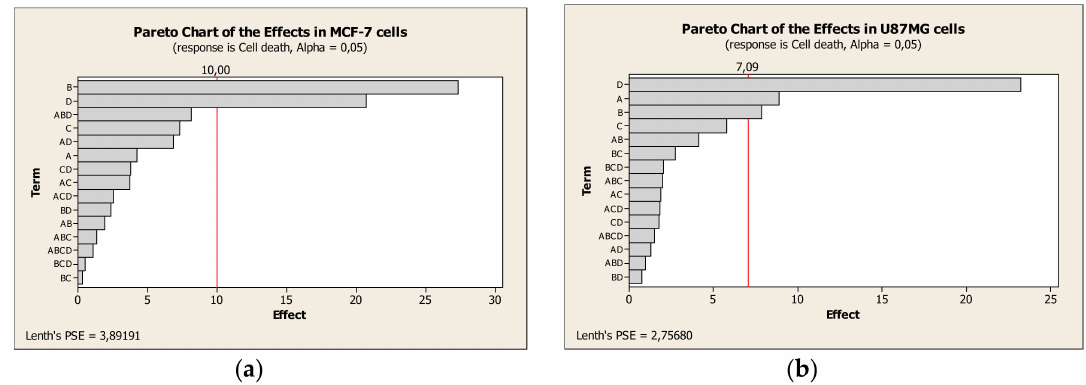
Figure 7. Standardized effects of A = functionalization, B = Dox concentration, C = nanocapsule concentration, D = period of incubation and their interaction effects on the cell death (( a ) MCF-7 cells; and ( b ) U87MG